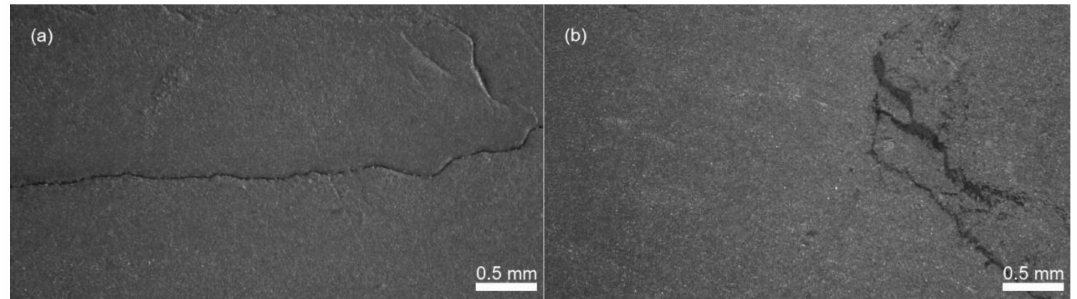
Figure 3. Relative mass loss during water debinding of CW- and AW-based feedstocks.